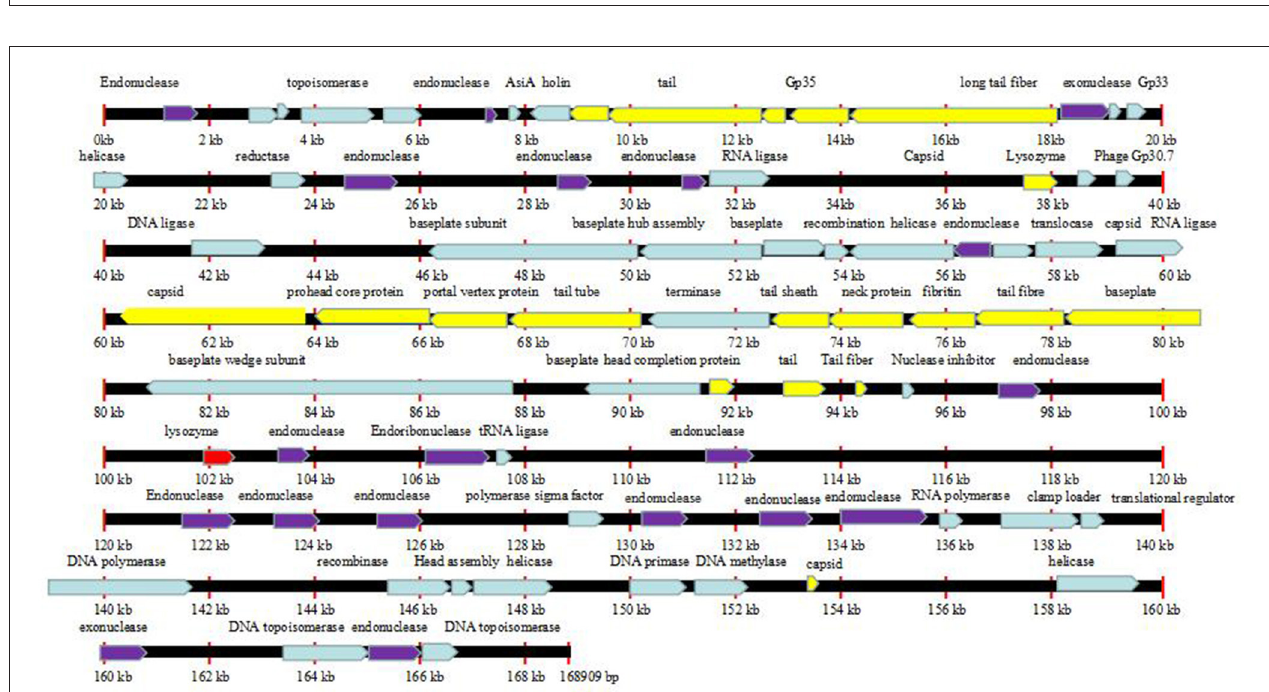
FIGURE 5 | Line map of the phage Flora genome. In the Flora map, genes colored red represent lysozymes, genes colored purple represent endonucleases, and genes colored yellow represent tail structure genes. The arrows represent the ORFs and indicate the direction of